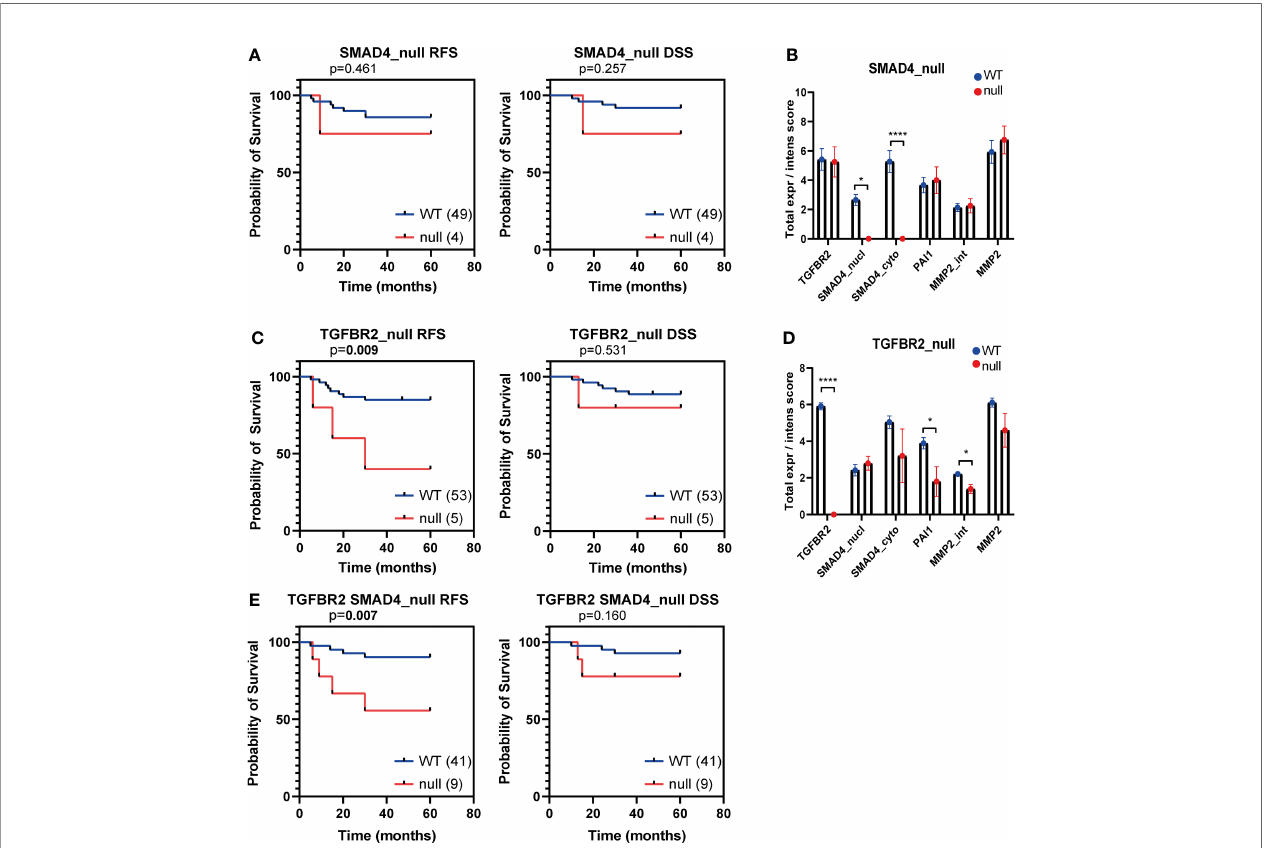
FIGURE 5 | Kaplan Meier curves for recurrence free survival (RFS) and disease speci fi c survival (DSS) for SMAD4 null and T b R2 null AC patients samples. Kaplan Meier curves for RFS and DSS of the institutional AC cohort, dichotomized based on SMAD4 null (A) , T b R2 null (C) , T b R2 null or SMAD4 null (E) expression. The number of patient samples included in each group is indicated between brackets in the legend. P values based on log-rank test, bold indicates signi fi cance (p ≤ 0.05). Protein expression of T b R2, SMAD4 (nuclear and cytoplasmic), PAI-1 and MMP2 were compared in T b R2 wild type versus null (B) and SMAD4 wild type versus null (D) . Signi fi cance is indicated with p<0.05 (*) and p<0.0001